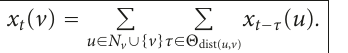
Figure 6: Nodes at a subset of the d -dimensional rectangular lattice, d = 2 depicted in the figure, with the connectivity induced by a √ transmission range r = d . The size of the network is controlled by K , with K = 5 in this figure.